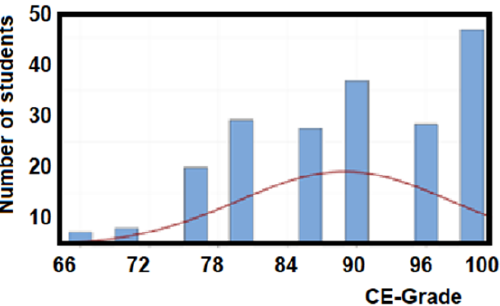
Figure 5. Statistics of certification grade (CE) for the EFR competency .